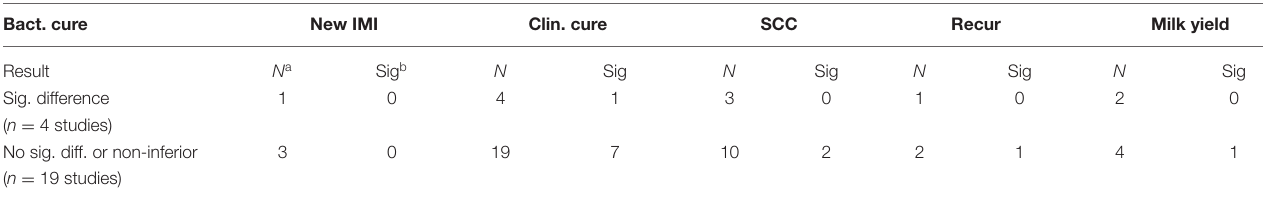
TABLE 4 | Statistical significance of other study outcomes categorized by significance of bacteriological cure in 23 clinical trials that evaluated bacteriological cure. Bact. cure New IMI Clin. cure SCC Recur Milk